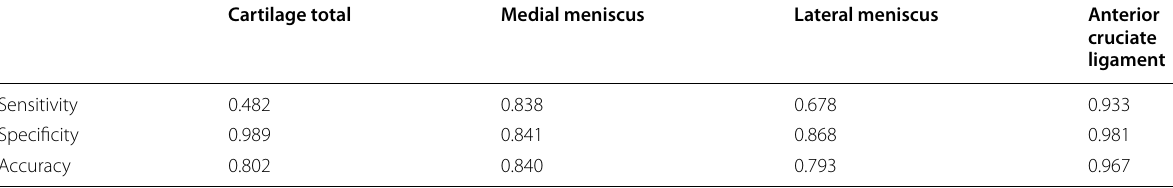
Table 3 Sensitivity, specificity, and accuracy of intraarticular structures